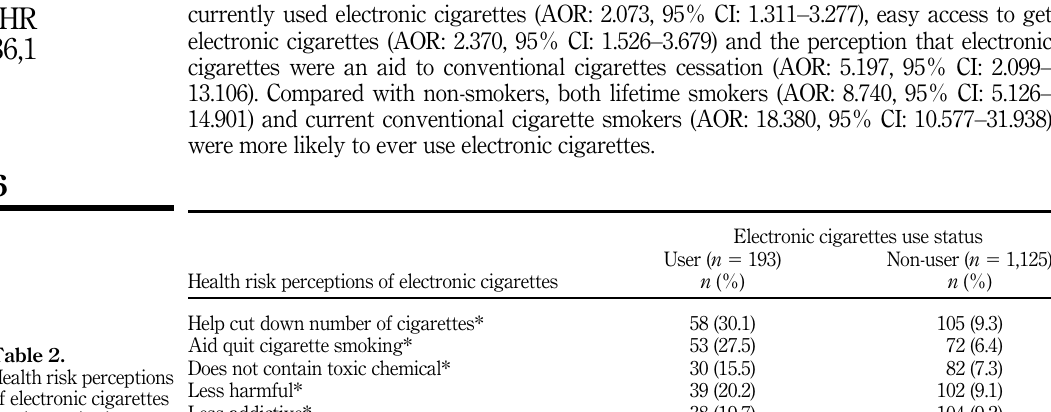
Table 2. Health risk perceptions